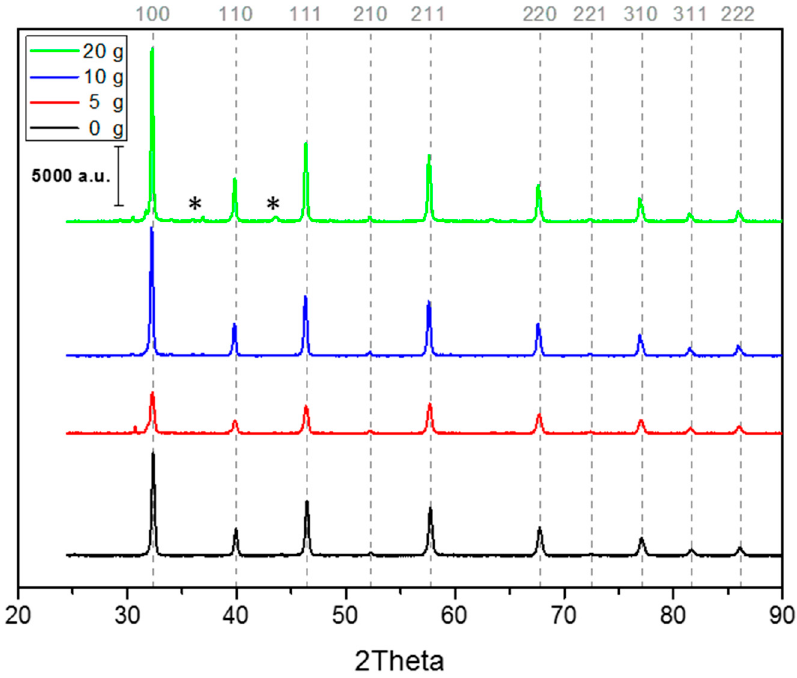
Figure 2. XRD patterns of the four materials synthesized. * Lithiated phase.